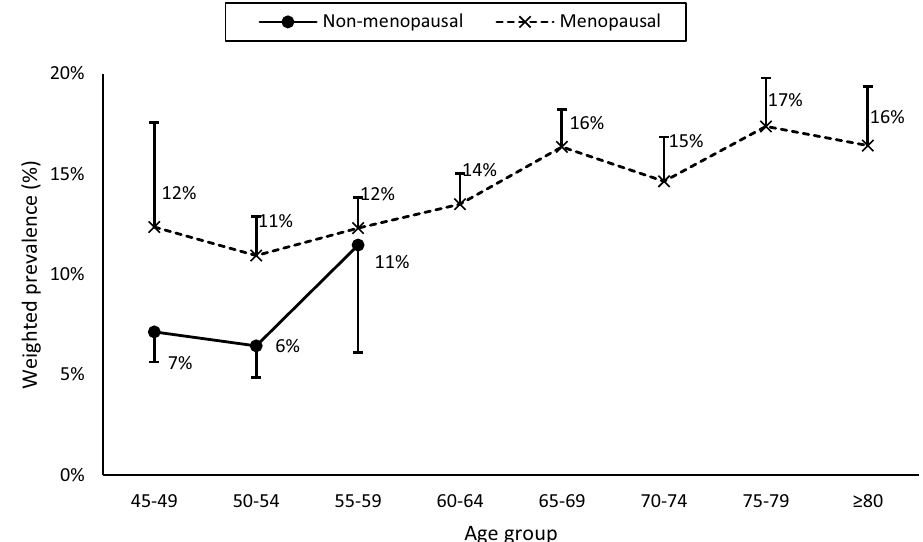
Figure 3. Prevalence of non-menopausal (solid curve) and post-menopausal (dashed curve) women at high- risk for OSA by age. Error bars represent the 95% confidence